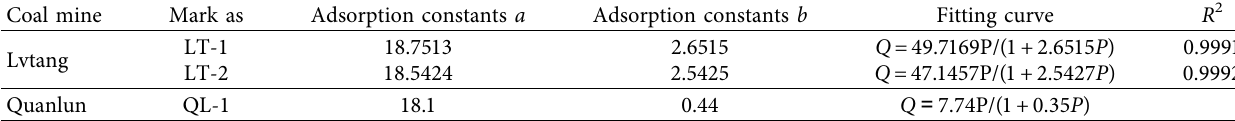
Table 4: Results of constant temperature adsorption experiment of the coal sample.